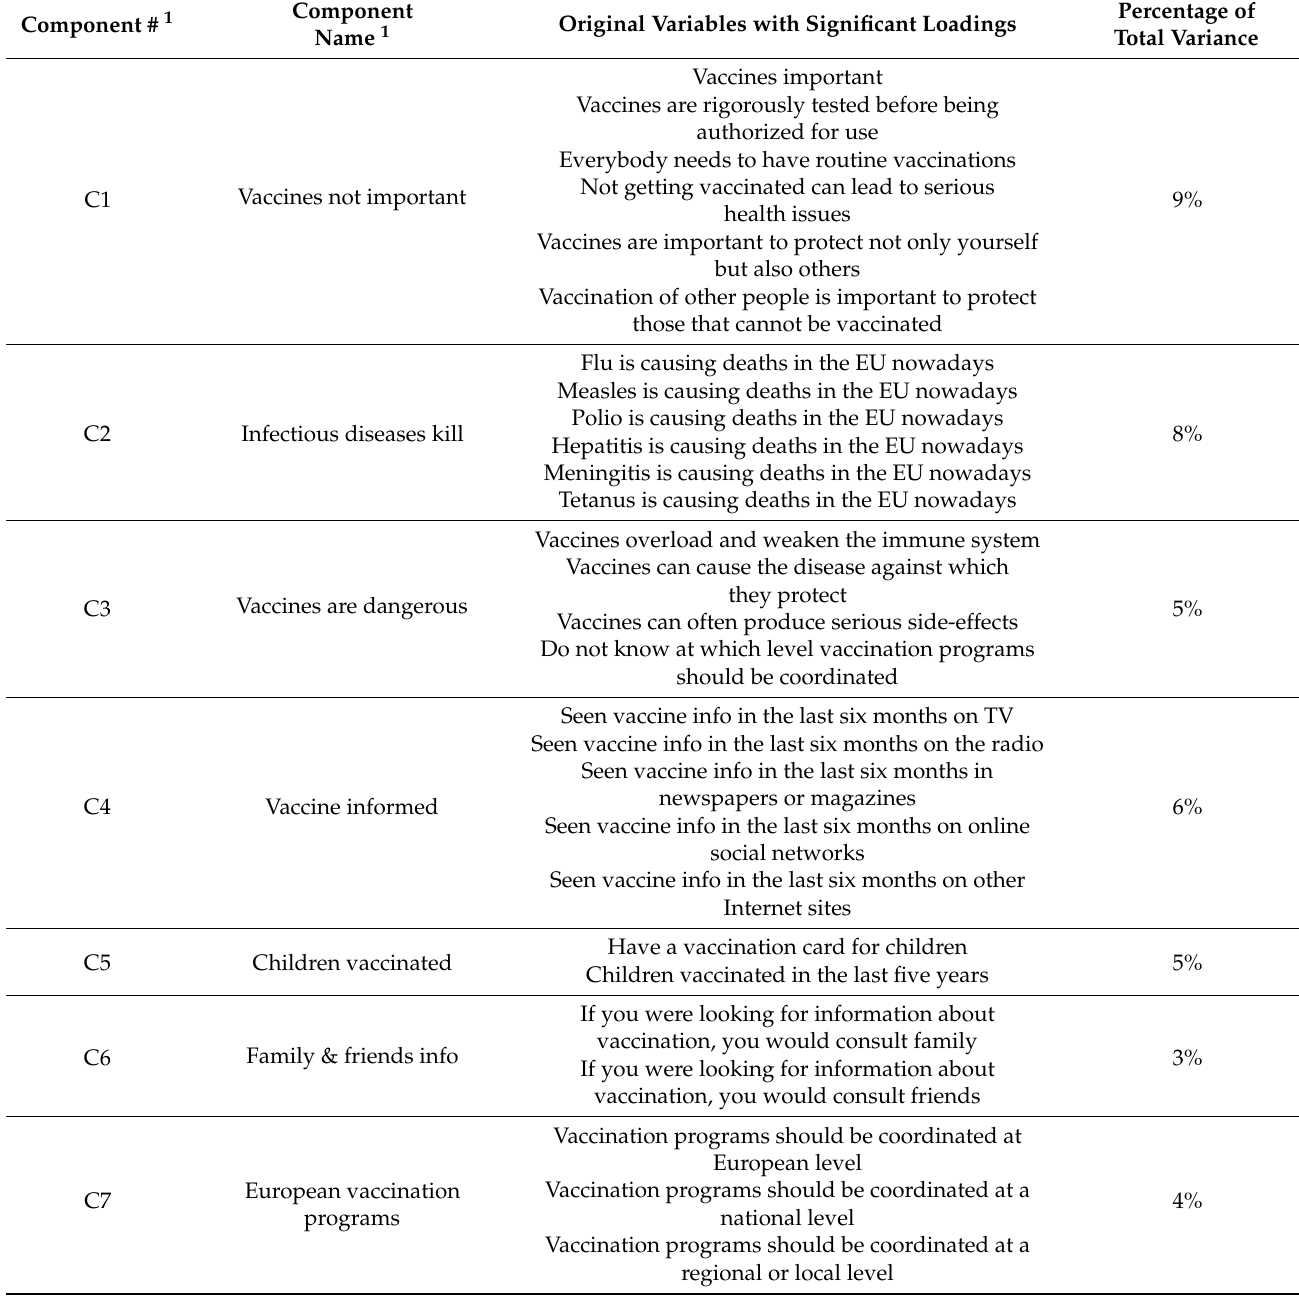
Table 2. Principal Components Analysis (Varimax